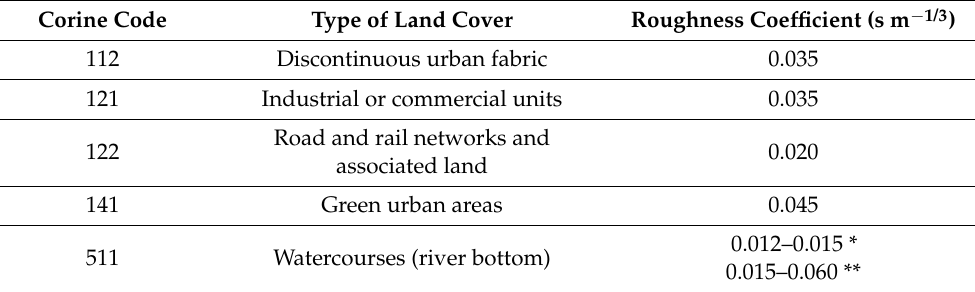
Table 6. Initial values of roughness coefficients assigned to land covers according to the Corine 2018